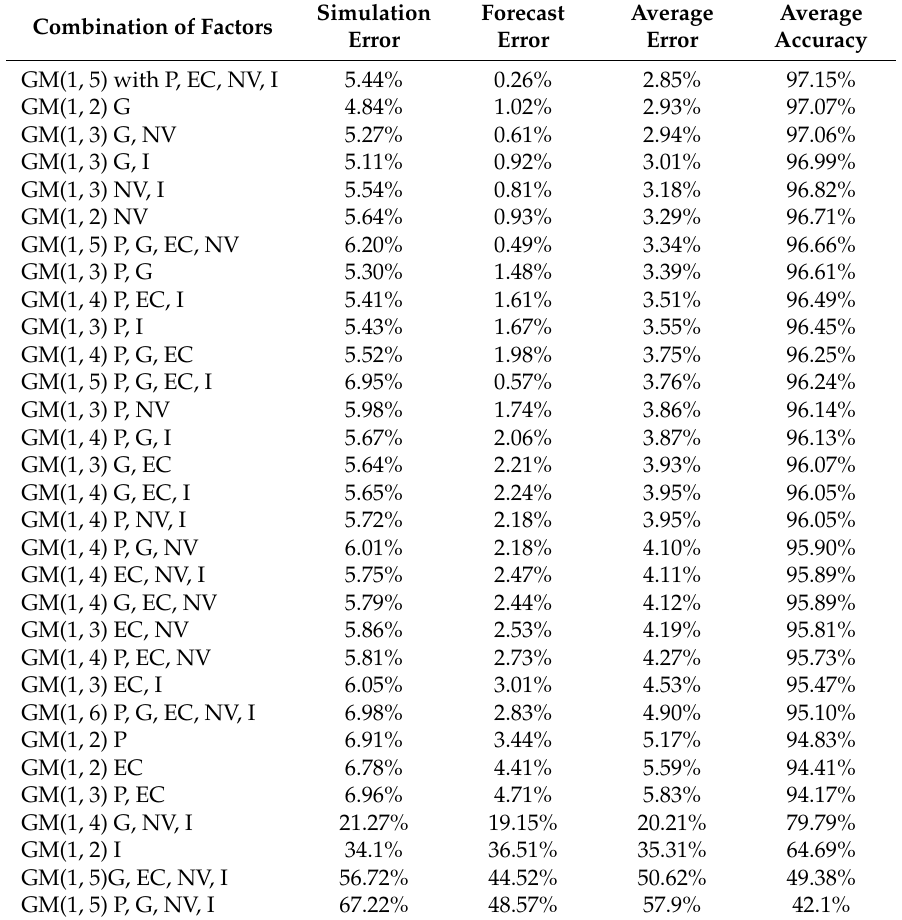
Table 8. The mean error and accuracy rate of GM(1, N ) model during the financial crisis (i.e., trained with the data from 2007–2010 and tested with the data in